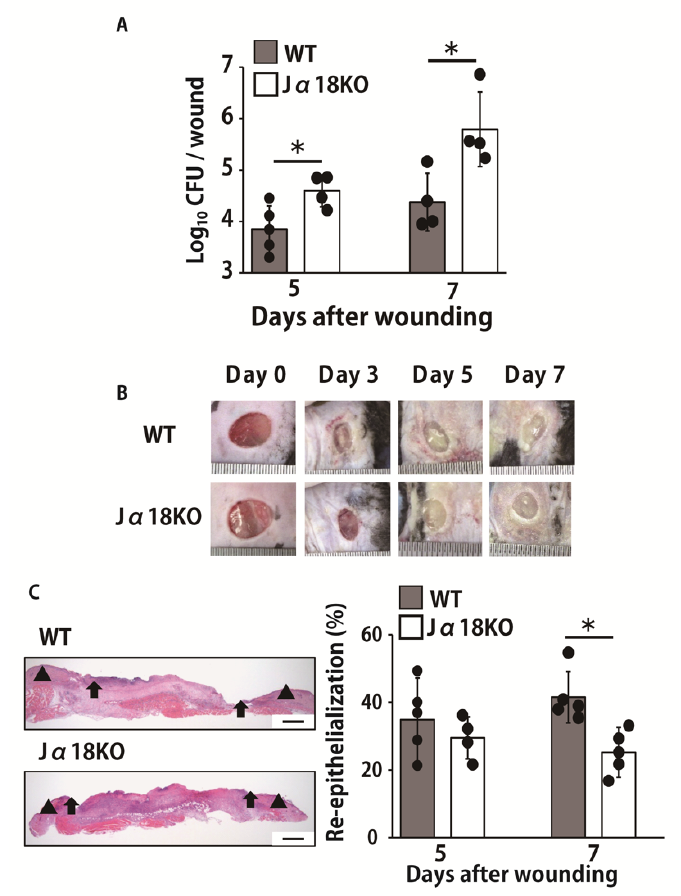
Figure 1. Effect of invariant natural killer T (iNKT) cell deficiency on the clearance of bacteria and re-epithelialization in wounds after inoculation with P. aeruginosa . Wounds were created on the backs of WT or J α 18KO mice, and P. aeruginosa strain PAO1 (0.7–1 × 10 4 colony forming units (CFUs)/wound) was directly inoculated at the wound sites immediately after wounding. ( A ) The number of live colonies in the wound on days 5 and 7 postinoculation were counted (n = 4–5). ( B ) Wound photograph in WT or J α 18KO mice. ( C ) Representative histologic views of skin wounds on day 7. Arrowheads and arrows indicate the original wound edges and re-epithelialized leading edges, respectively. Scale bar, 500 μ m. Time-course changes in the re-epithelialization ratio after wound creation (n = 4–5). Black circles represent one individual mouse. Each column represents the mean ± standard deviation (SD). The results are representative of at least two independent experiments. * p < 0.05.